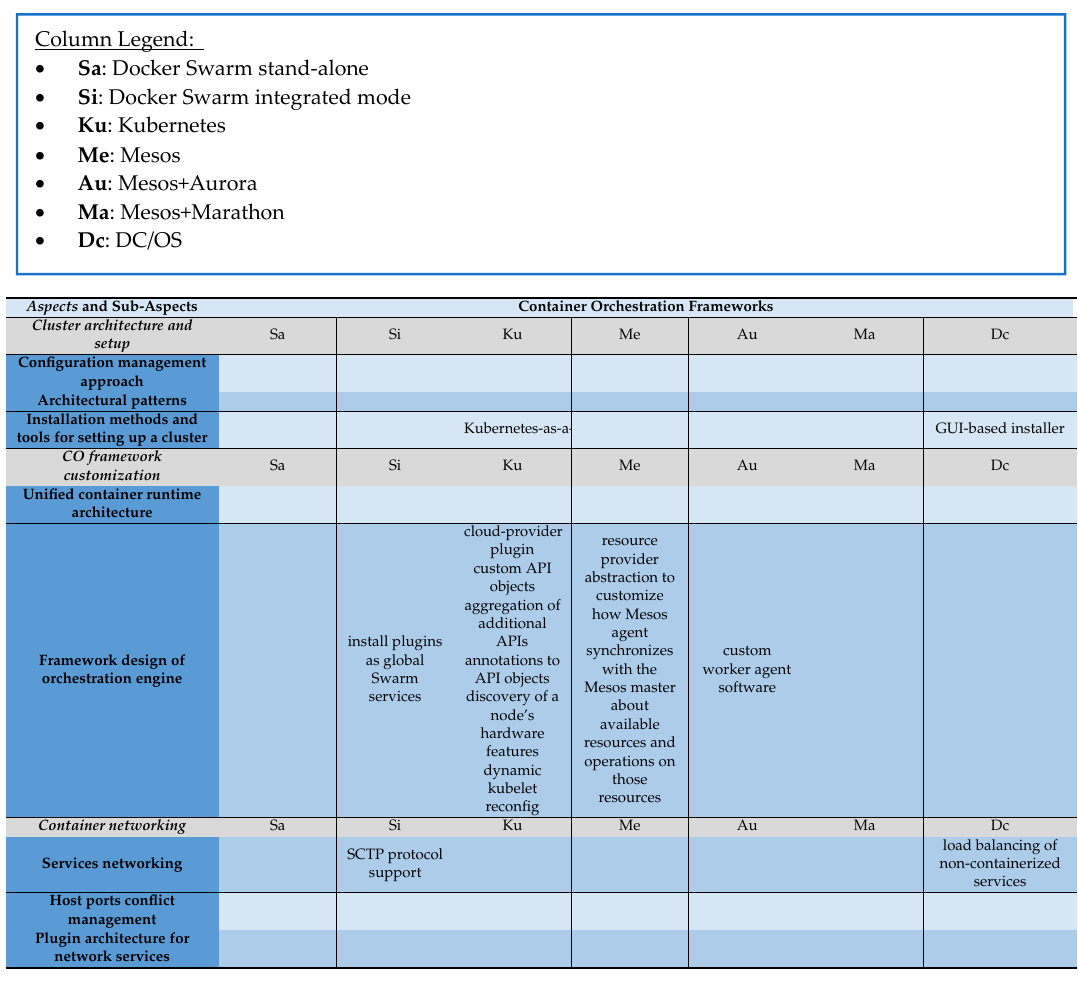
Table A1 . Unique features of Docker Swarm, Kubernetes, Mesos, Aurora, Marathon and Table A1. Unique features of Docker Swarm, Kubernetes, Mesos, Aurora, Marathon and DC/OS.